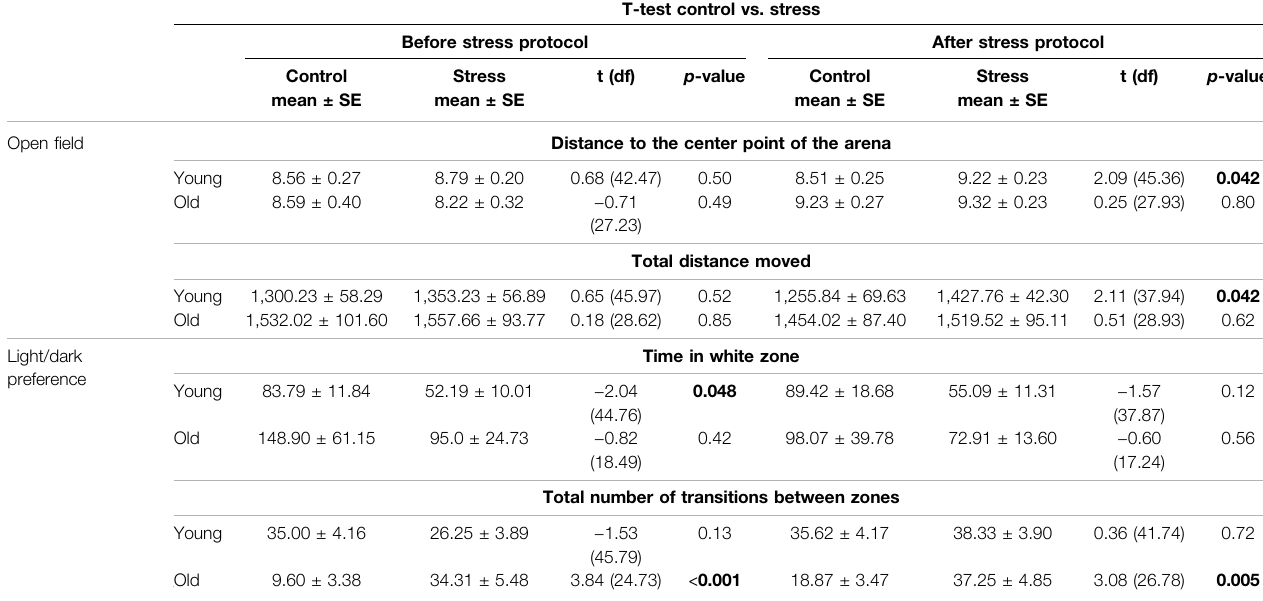
T-test control vs.